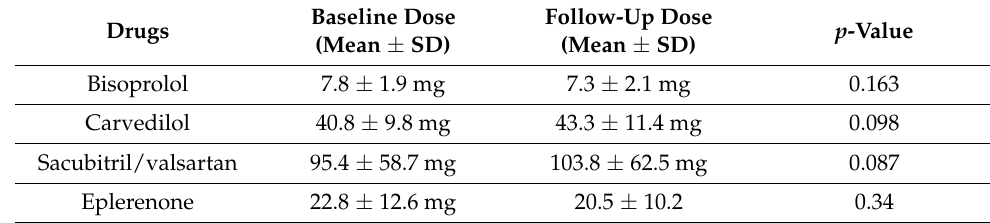
Table 2. Comparison of disease modifiers drugs dosage before and after CCM